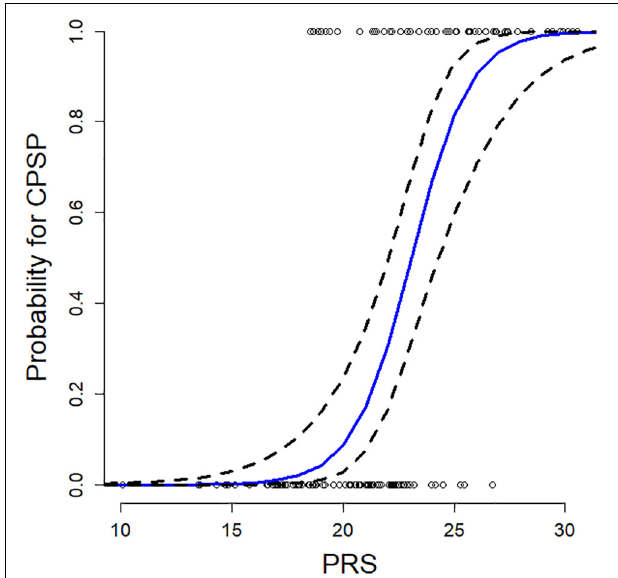
FIGURE 3 | Plot of predicted probability of developing chronic postsurgical pain (CPSP) after spine surgery is presented as a function of polygenic risk score (PRS), at a childhood anxiety sensitivity index (CASI) score of 28.3 (median CASI in the model). The blue line denotes predicted probabilities from the final regression model, and dashed lines the 95% confidence interval, and circles represent observed cases (or outcomes). We see a sigmoid shaped curve with increasing probability of CPSP at PRS > 16, 50% probability at PRS = 23.06 and high probability beyond PRS = 30. Thus, higher the weighted PRS, higher the probability of CPSP.